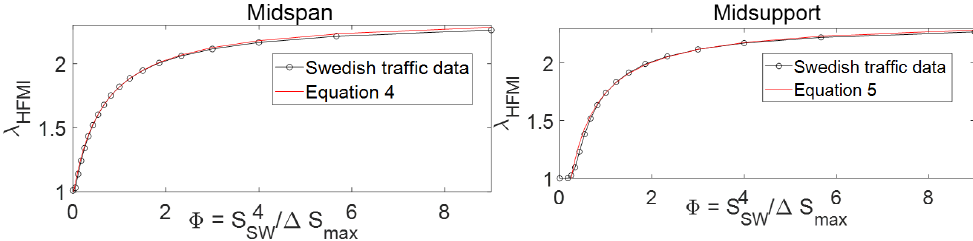
Figure 7. Comparison of Φ – λ HFMI curves calculated using the extended Swedish data and Equations (4) and (5) for the mid-span and mid-support sections,